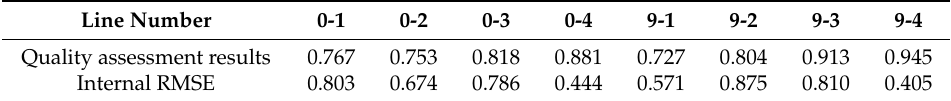
Table 5. Standard deviation of four factors and internal RMSE in two repeat line flight.